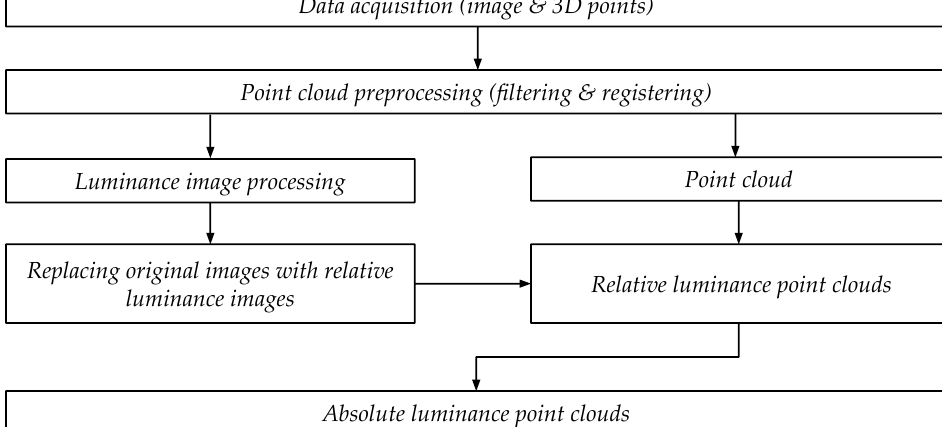
Figure 6. The workflow for creating data for indoor 3D luminance